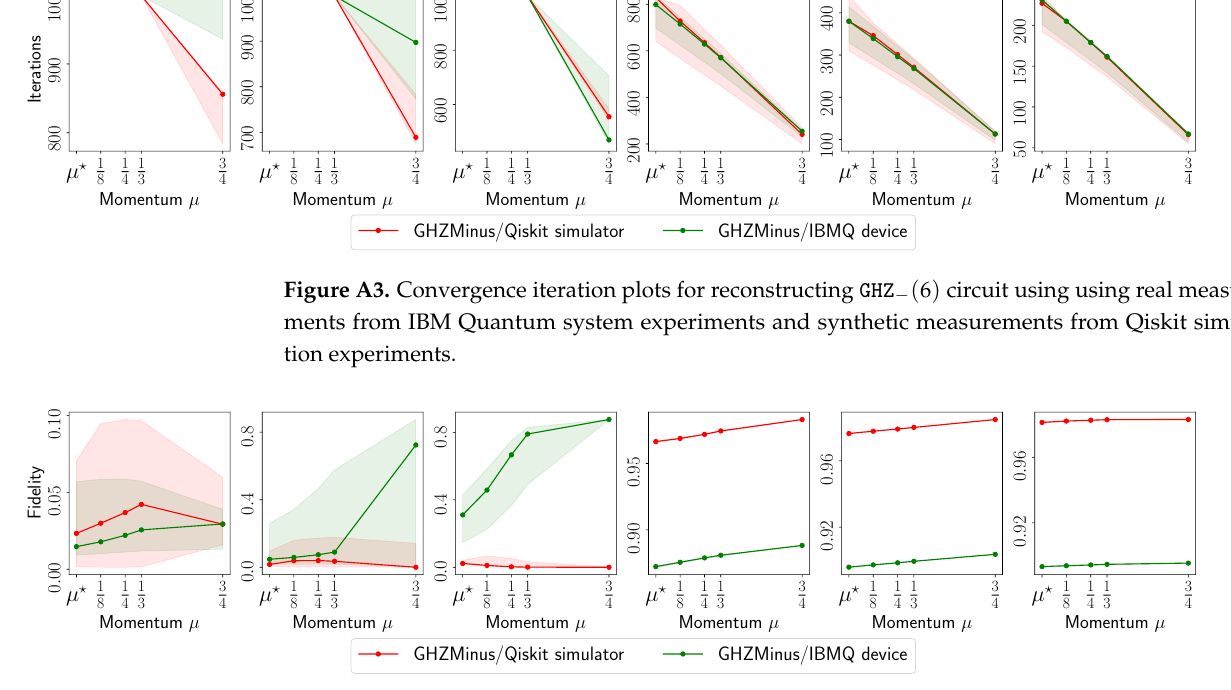
( 6 ) circuit using using real measurements from −